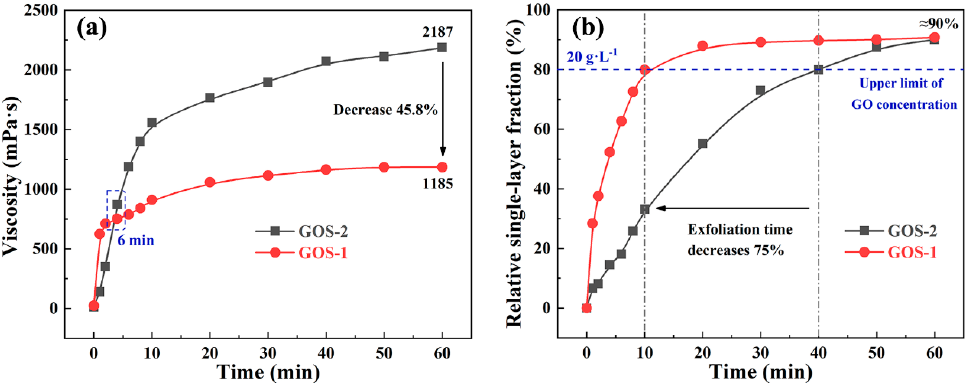
Figure 8. ( a ) Viscosity and ( b ) relative single-layer fraction of GOS-1 and GOS-2 with the extension of shear